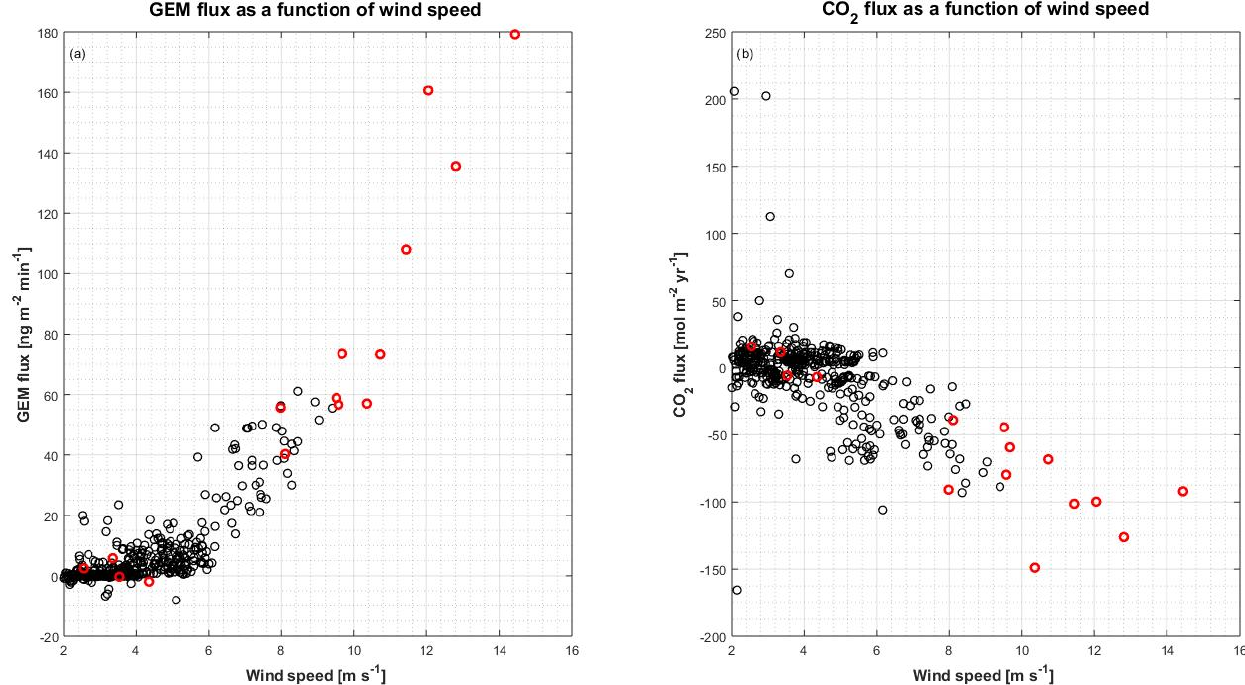
Figure 10. Relation between GEM and CO 2 flux and wind speed. (a) GEM flux in ngm − 2 min − 1 as a function of wind speed, and (b) CO 2 flux in molm − 2 yr − 1 as a function of wind speed. The red circles are data from the period starting on 30 April, which are considered as outliers (see the text for further explanation). Table 2. Mean and SD of GEM and CO 2 fluxes in different temper- ature ranges calculated from the data sampled at Station Nord from 23 April to 12 May in 2016. Temp. range Mean GEM flux Mean CO 2